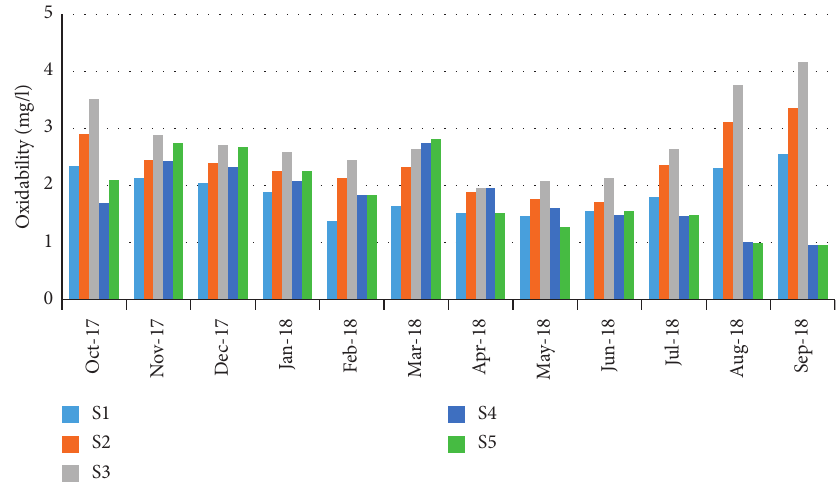
Figure 15: Spatial-temporal variation of oxidability matter in the Zegzel watercourse. Table 6: Weighted quality index values and surface water quality class of the Zegzel